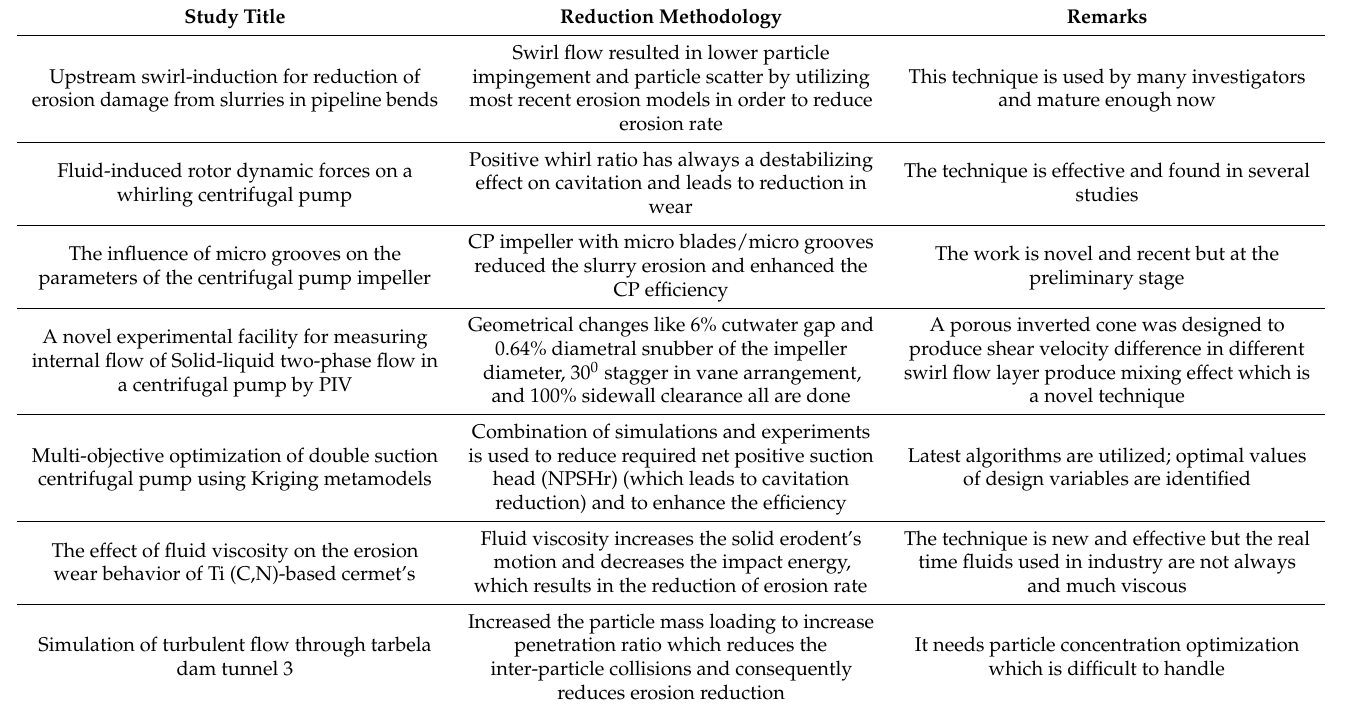
Table 3. Important and latest techniques utilized for erosion